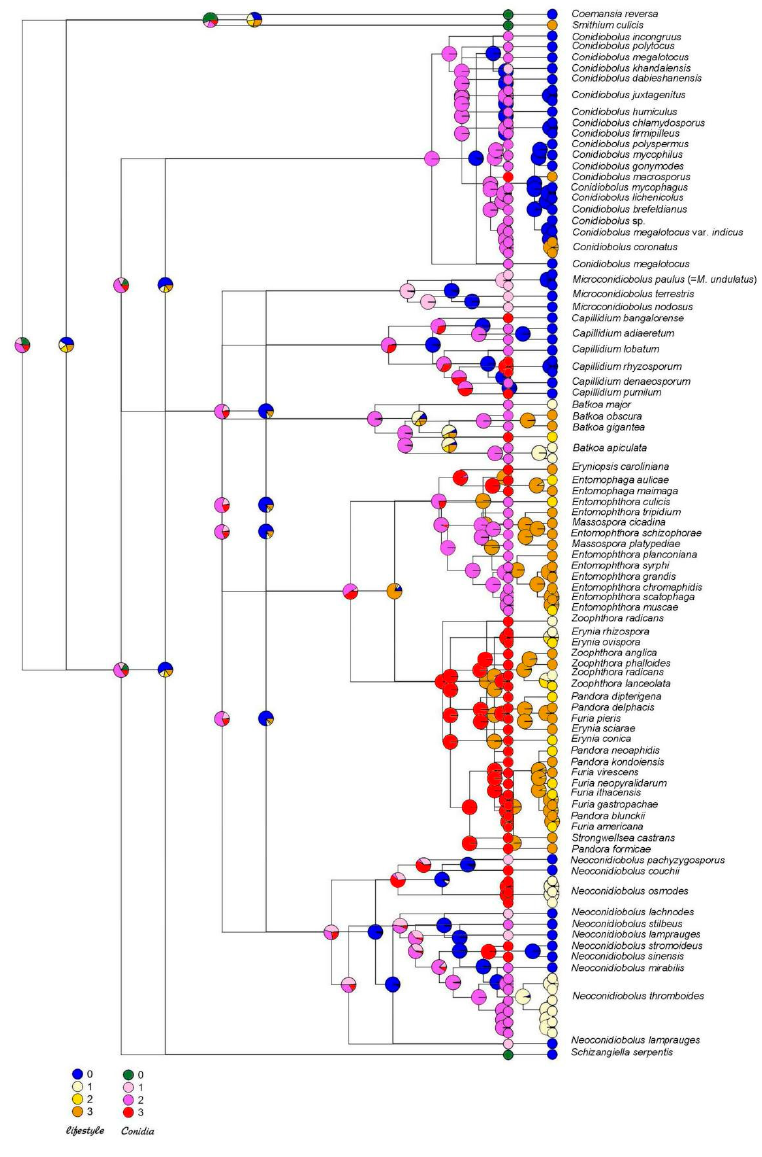
Figure 3. Ancestral State Reconstruction suggests ballistic conidia evolutionarily precedes the par- asitic lifestyle. Reconstruction is done for four states. Lifestyle: non-pathogenic to insects, grow well on artificial media (0, blue), insect pathogen of wide range, growing well on artificial media (1, beige), insect pathogen of moderate range (2, yellow), insect pathogen of narrow range (3, orange). Ballistic conidia: not forcible, absent, or unknown (0, green), forcible small and round ≤ 20 µ m (1, pink), forcible large and round (>20 µ m) in diameter (2, purple), presence of forcible conidia other than round (3,